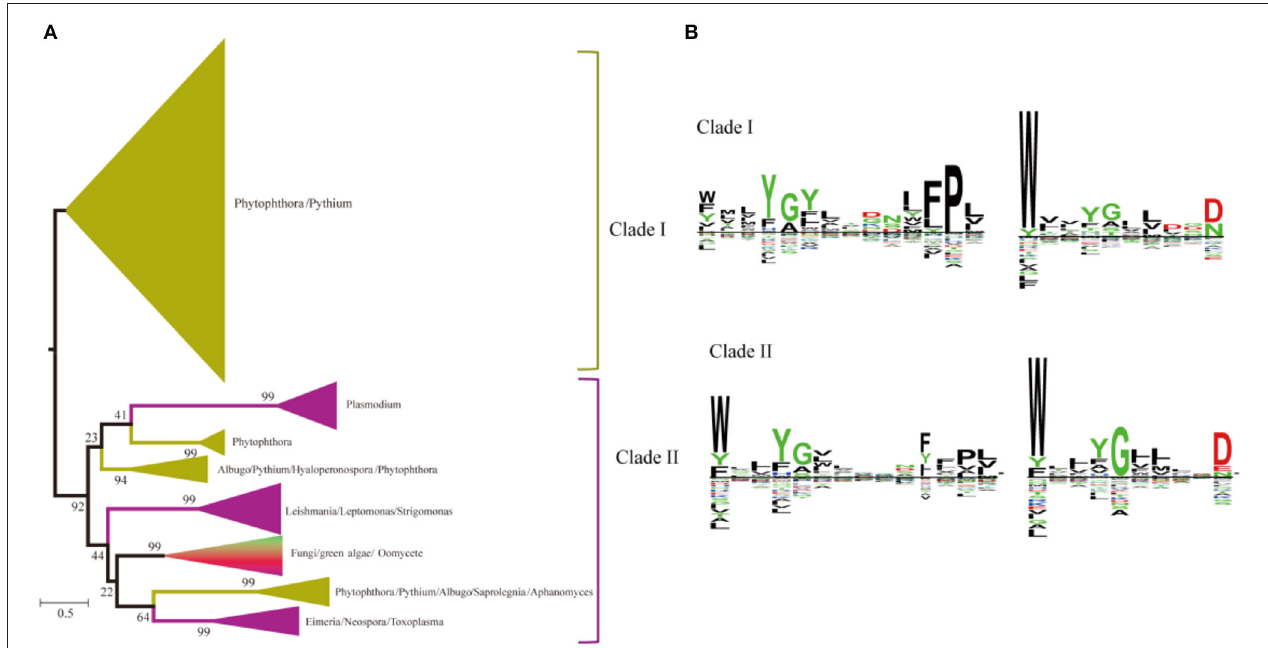
FIGURE 6 | Phylogenetic and conserved motif analyses of SWEETs from unicellular eukaryotes and fungi. (A) Molecular phylogenetic analysis by the maximum likelihood method. The tree with the highest log likelihood ( − 116121.8598) is shown. The tree is drawn to scale, with branch lengths indicating the number of substitutions per site. Evolutionary analyses were conducted in MEGA7. (B) Sequence alignment of conserved motifs of SWEETs in different clades corresponding to (A) . The sequences were aligned by ClustalW. The conservation level of each residue is indicated by the height of the bar above it. The sequence logo was generated using Seq2Logo.